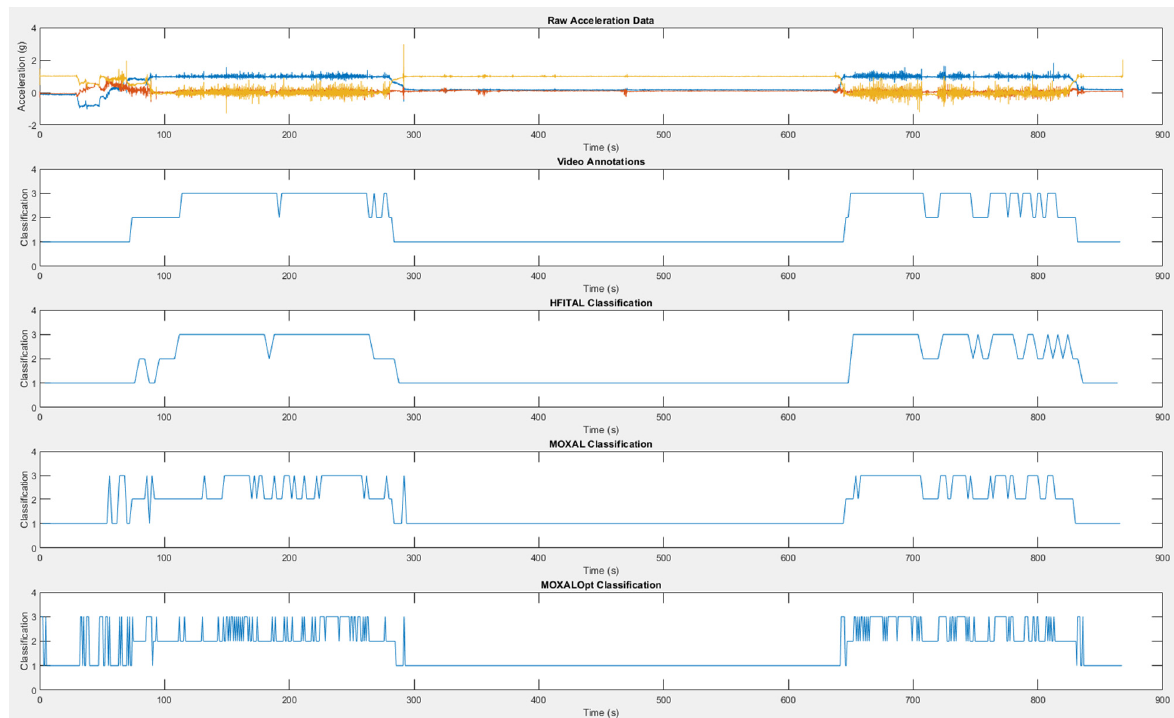
Figure A2. A graphical representation of the raw acceleration data, the video annotations and the classification of HFITAL, MOXAL, and MOXAL Opt . The values 1, 2, 3, correspond to sedentary, standing, and dynamic activity, respectively. MOX- AL Opt = classification algorithm after optimization of three adjustable parameter settings of MOXAL to reduce the absolute percentage error for total activity. HFITAL = classification algorithm after additional modifications were introduced to MOXAL regarding the decision tree and the calculation of the amount of physical activity.